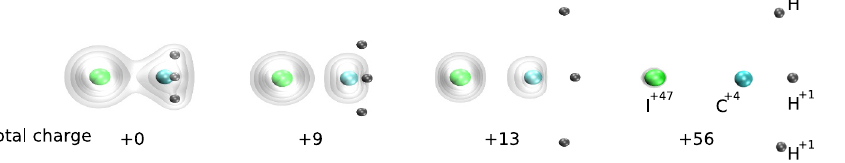
Figure 2. Illustration of the dynamics of a CH 3 I molecule exposed to intense x-ray radiation. Four snapshots at di ff erent charge states are shown. The gray cloud indicates the electron